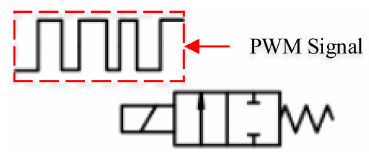
Figure 3. High-speed switching two-way valve controlled by pulse width modulation